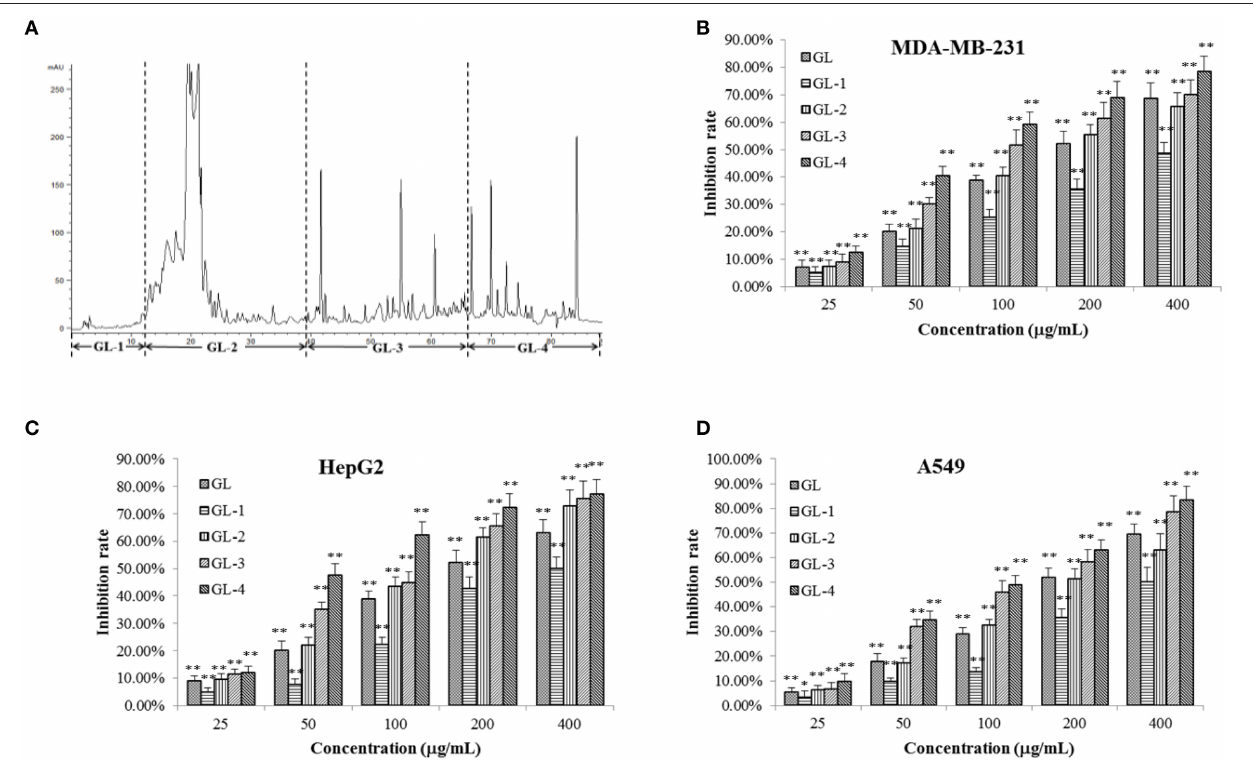
FIGURE 2 | Chromatrogram of the GL extract (A) at 254nm and anti-proliferative effects of its fractions against MDA-MB-231 (B) , HepG2 (C), and A549 (D) cells. The asterisms indicate that the values were significantly different from the controls (* p < 0.05, ** p <